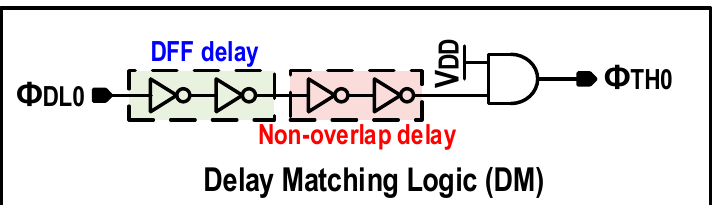
Figure 12. DM logic.